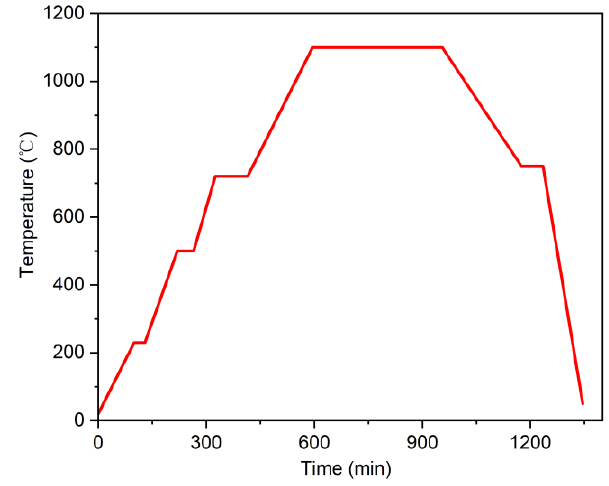
Figure 2. A typical sintering curve for Ti-6Al-4V.